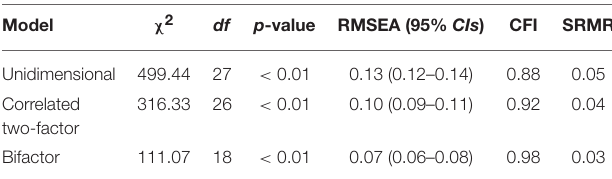
TABLE 2 | Fit statistics of CFA models.